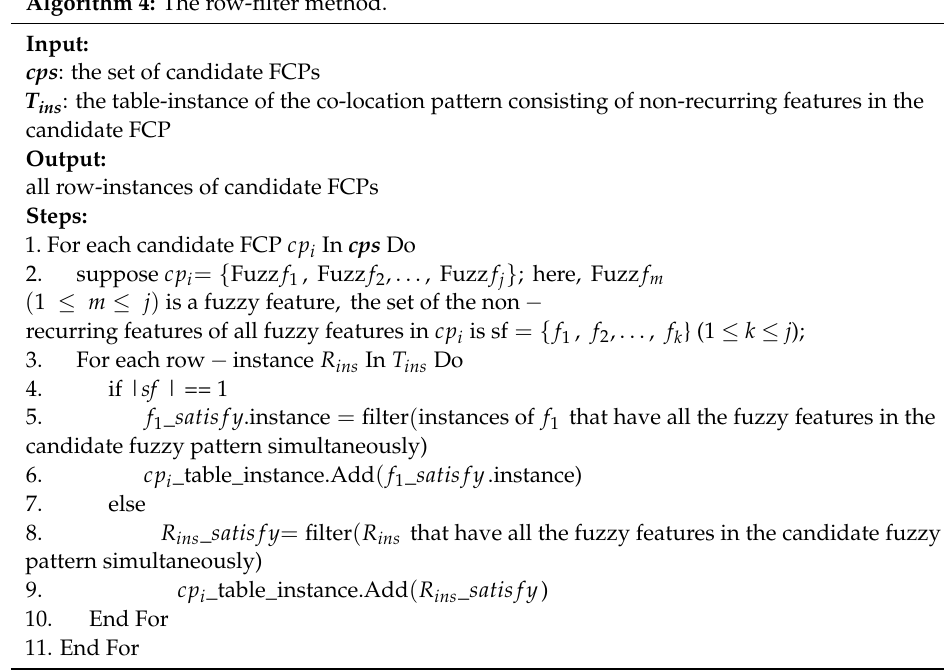
Algorithm 4: The row-filter